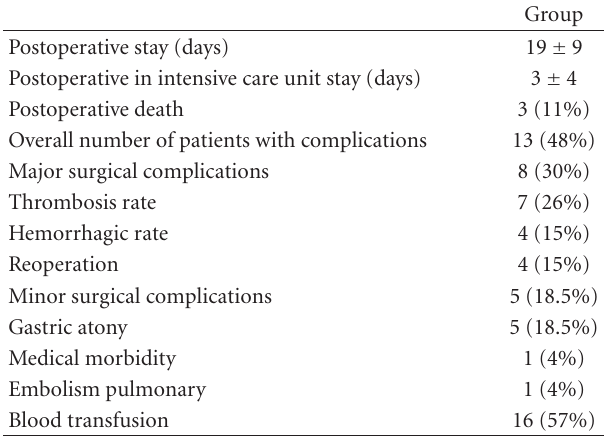
Table 2: Morbidity and mortality for all patients with venous